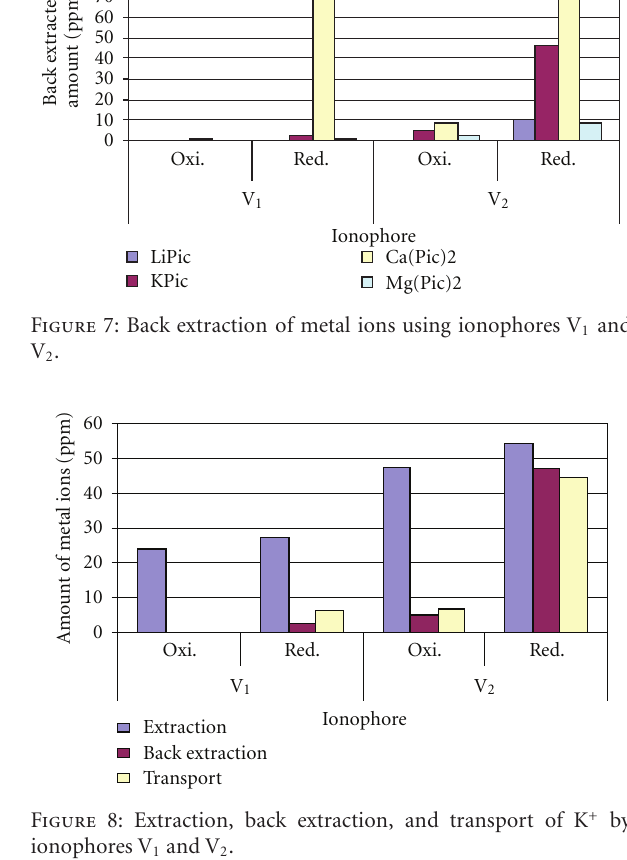
Figure 3: Cyclic voltammograms of ionophore V 2 ( − 735mV). Scan rate 100(mV/s) and switching potential from 1100mV to − 1500mV.